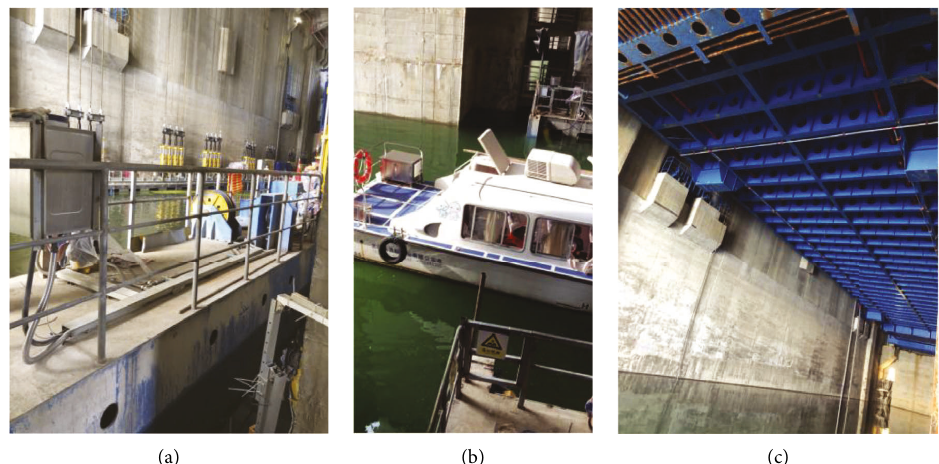
Figure 1: Launching ship lift at Goupitan dam. (a) The ship lift docks with the downstream. (b) Ship enters the ship lift. (c) The ship lift is out of the